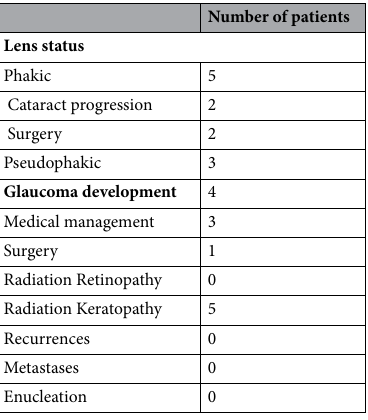
Table 3. Complications following radiation treatment for iris